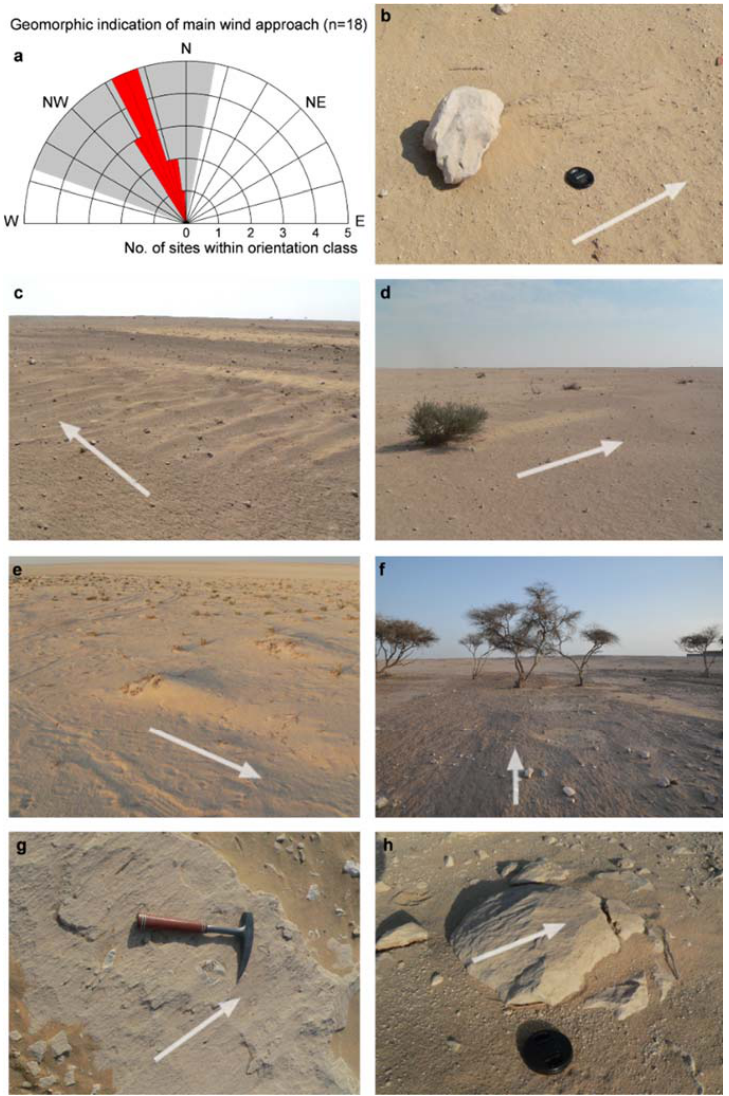
Figure 3. ( a ) Direction of geomorphic indicators of long ‐ term Shamal predominance mapped during the field survey (yellow dots in Figure 1a). The wider Shamal corridor of 290°–010° is grey ‐ shaded; ( b ) Micro ‐ yardang inside a rawdha indicating deflation in these silt/sand ‐ filled karstic depressions. Its formation is triggered by protection through a larger boulder; ( c ) Transversal wind ripples perpendicular to Shamal direction, c. 10 cm high; ( d ) Incipient nebkha associated with a long drape of sand developed in the lee of a shrub; ( e ) Small herbaceous nebkha with shorter leeward tail; ( f ) Linear corrasion features on a rawdha surface; ( g ) Linear corrasion features on a MIS 5 beachrock (see “Pleistocene beach ridge” in Figure 1b) [25]; ( h ) Linear corrasion features on subaerially exposed Dammam limestone. All arrows point into the downwind Shamal direction.